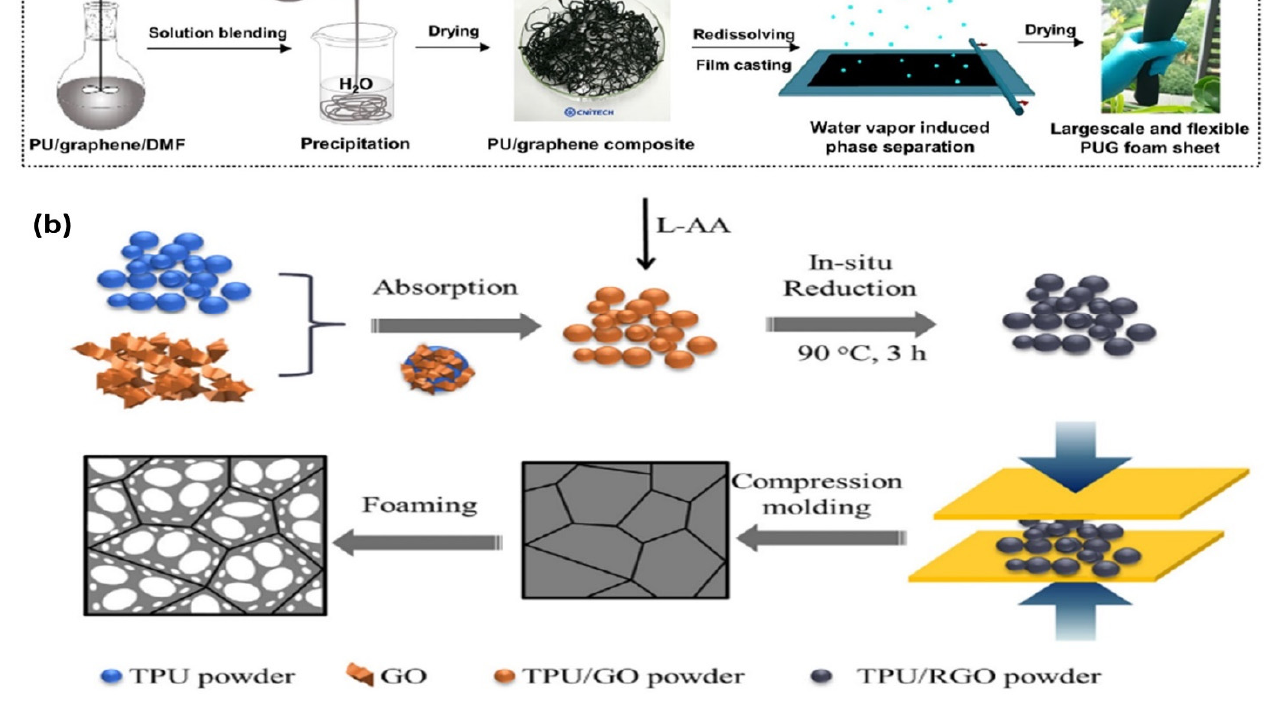
Figure 10. ( a ) Schematic depicting the fabrication process of PU-graphene foams. ( b ) Schematic showing the preparation technique of TPU/RGO composite foams. Reproduced with permission from [111,112]. Copyright 2019, 2017 Elsevier Ltd.